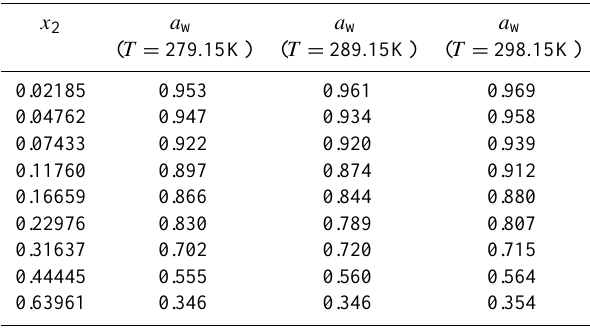
Table 5. Bulk water activity (a w ) measurements ∗ of water (1) + methoxyacetic acid (2) solutions at three different temperatures. So- lution compositions are given in mole fraction ( x 2 ) of the organic component